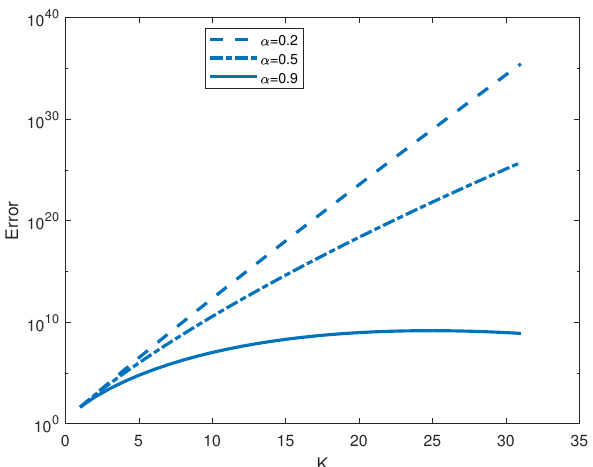
Figure 1. Relative error Vs number of terms K in the series (5) for three values of α , β = 1 and the matrix A as in Equation